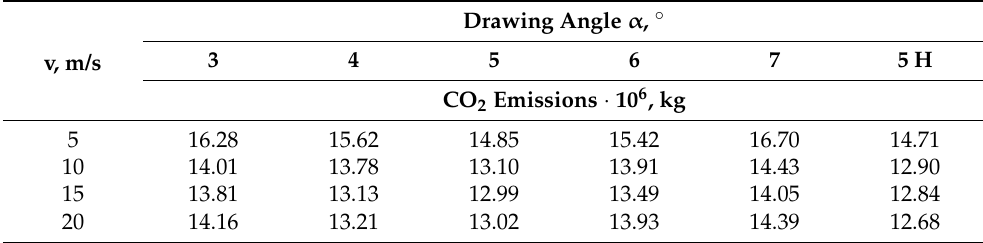
Table 3. CO 2 emissions related to the consumption of electric energy E required to manufacture 100,000 tons of 2.2 mm wire, depending on the drawing technology used, where α —drawing angle, H—hydrodynamic dies, v—drawing